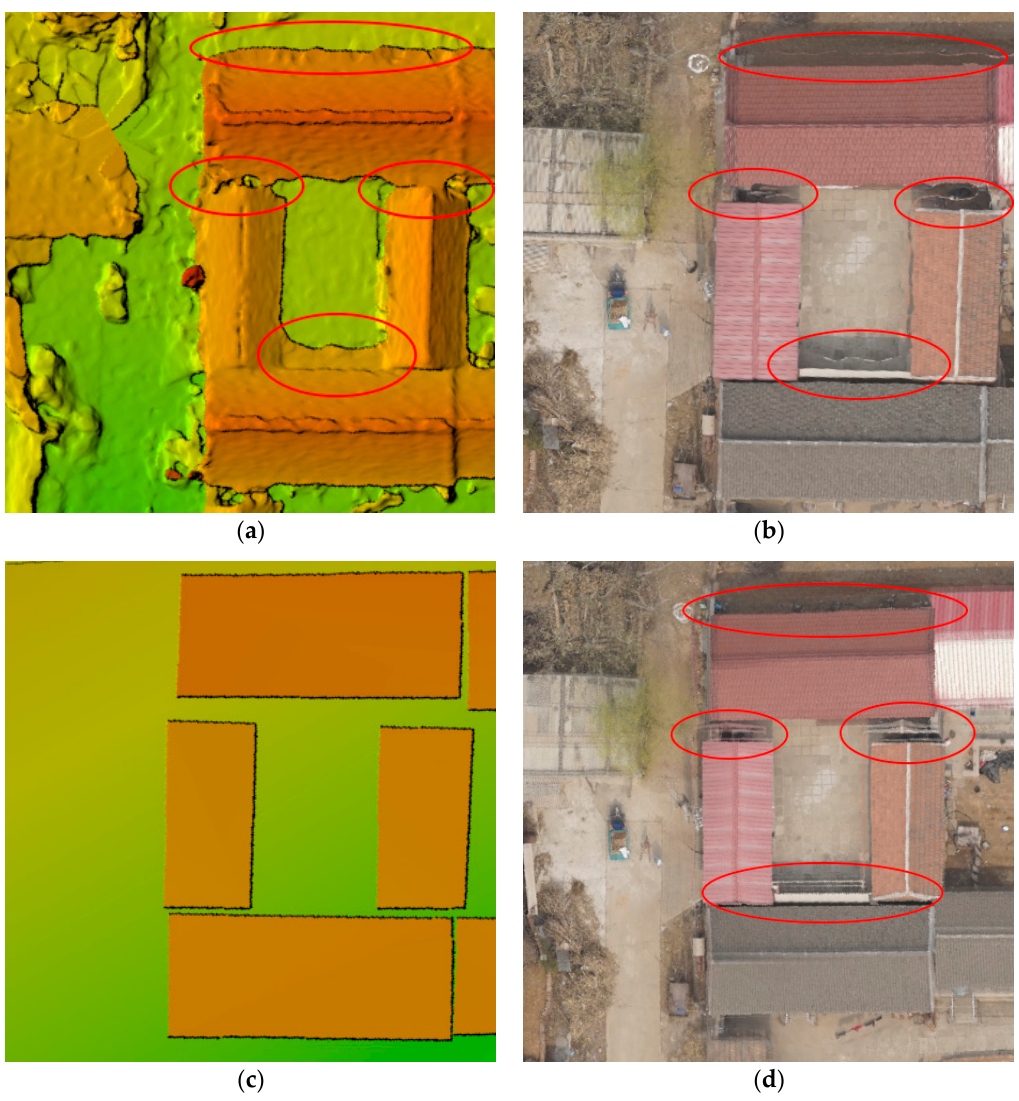
Figure 7. ( a ) Original DSM; ( b ) original DOM; ( c ) revised DSM; and ( d ) the DOM generated by the revised DSM.